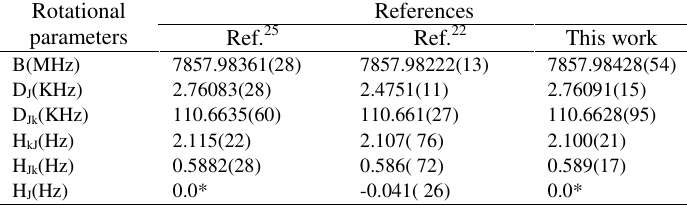
CN in the ground state with previous 3